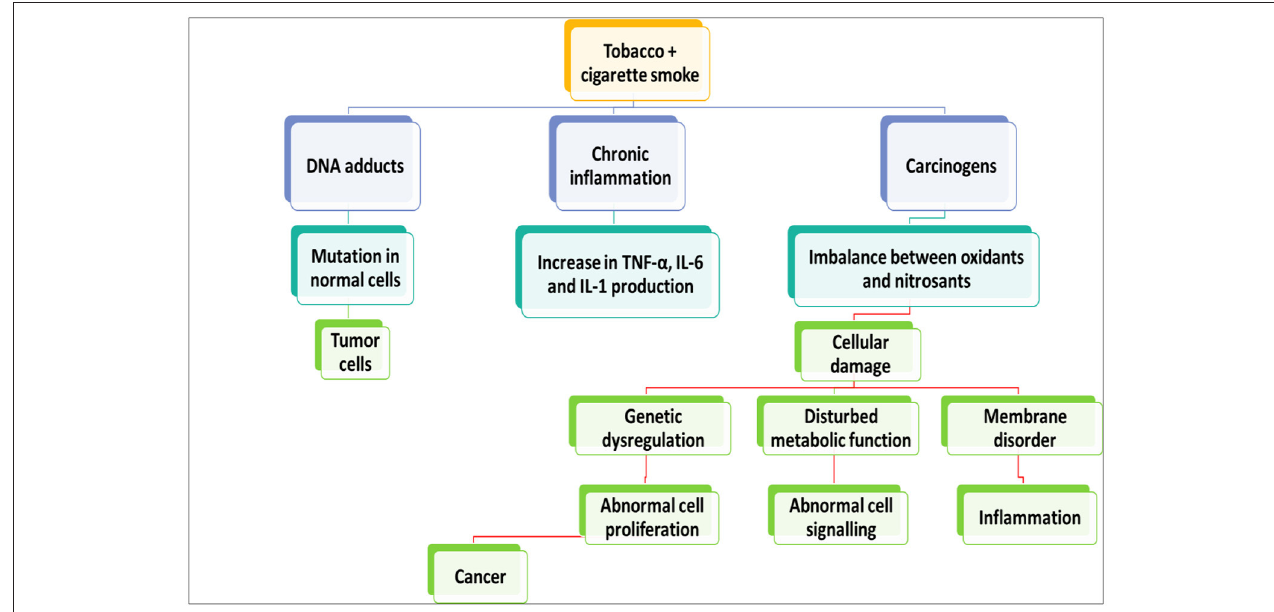
FIGURE 4 | Links between the oxidative and nitrosative induced damage and progression of